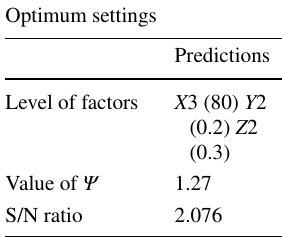
Table 9 Composite primary components with s/n ratio, regression